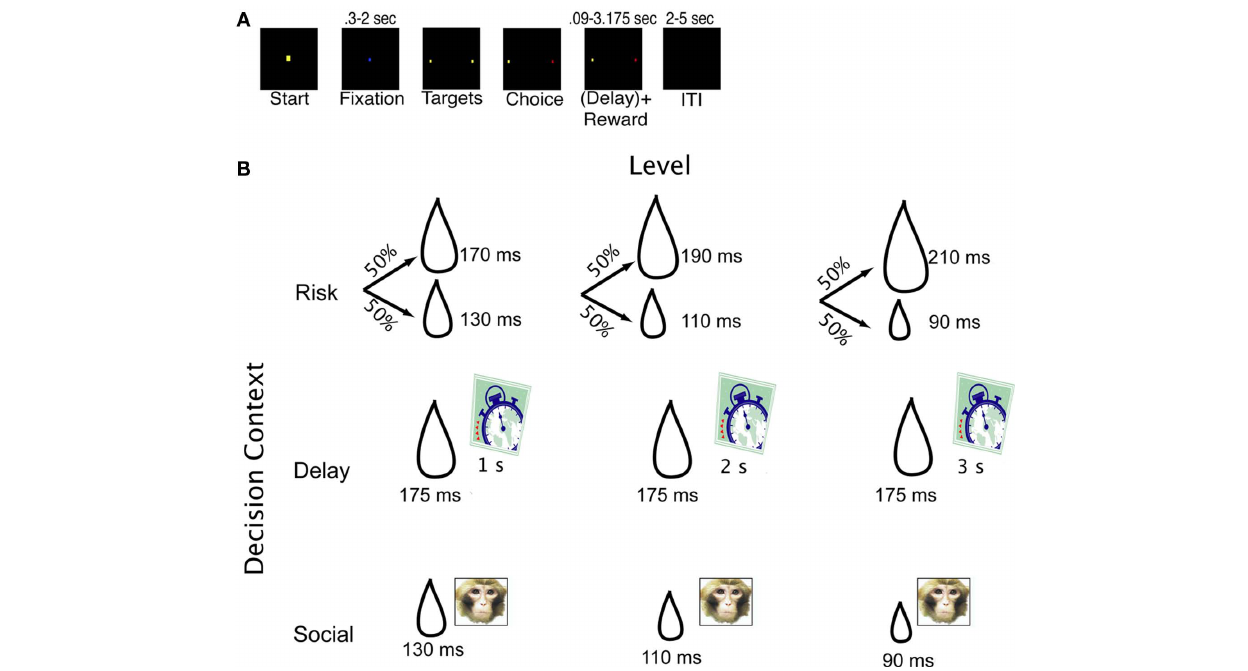
approximately the same total length. (B) Reward matrix showing outlier outcomes for each level of each context. All recording sessions included blocks composed of one of nine trial types: three conditions (risk, delay, social), each with three levels. Clock indicates delay to reward, the droplet indicates amount of juice delivered, and the picture indicates that a social reward was presented just before juice delivery. The standard option was always 200 μL of juice available immediately, with no